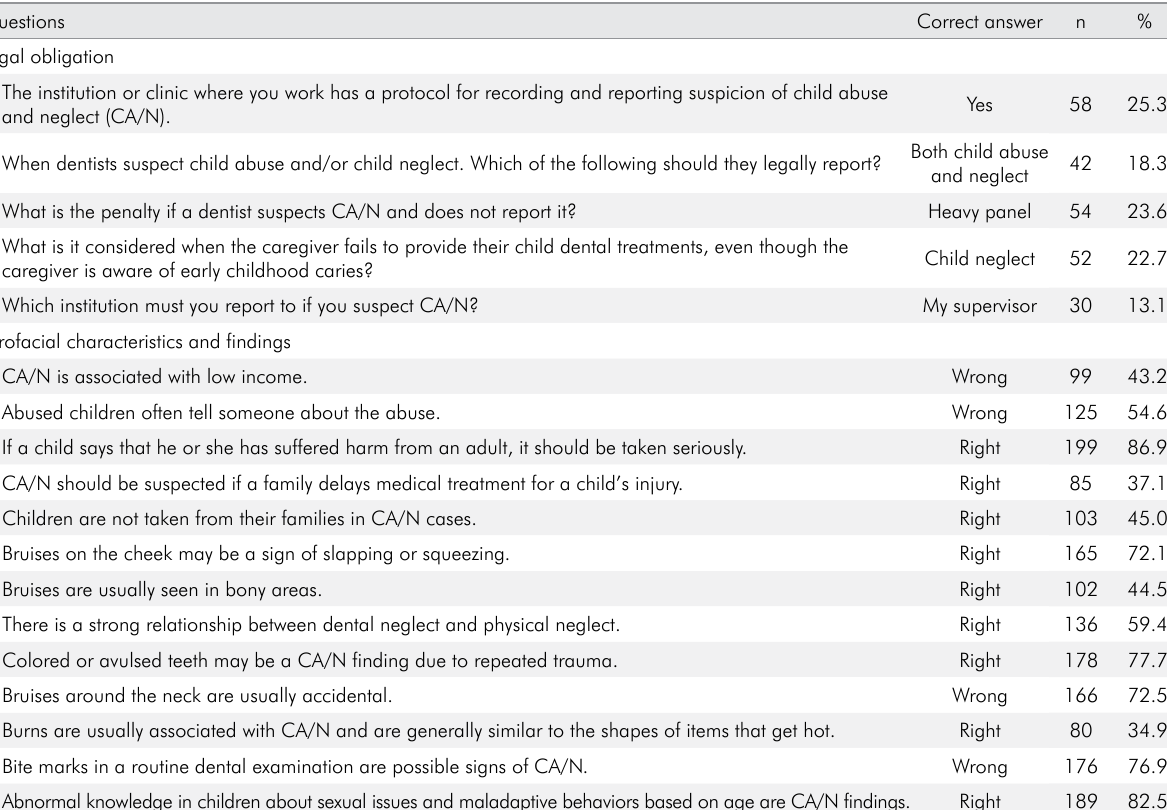
Table 2. Distribution of correct answers by participants for each question for knowledge about legal procedures and the orofacial characteristics and findings that are indicative of child abuse and neglect.